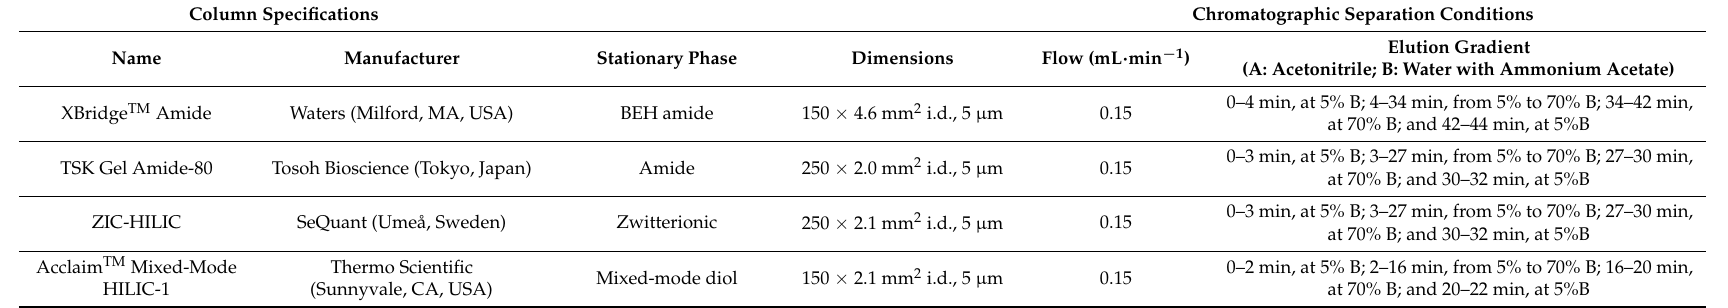
Table 3. HILIC column specifications and chromatographic separation conditions used during the